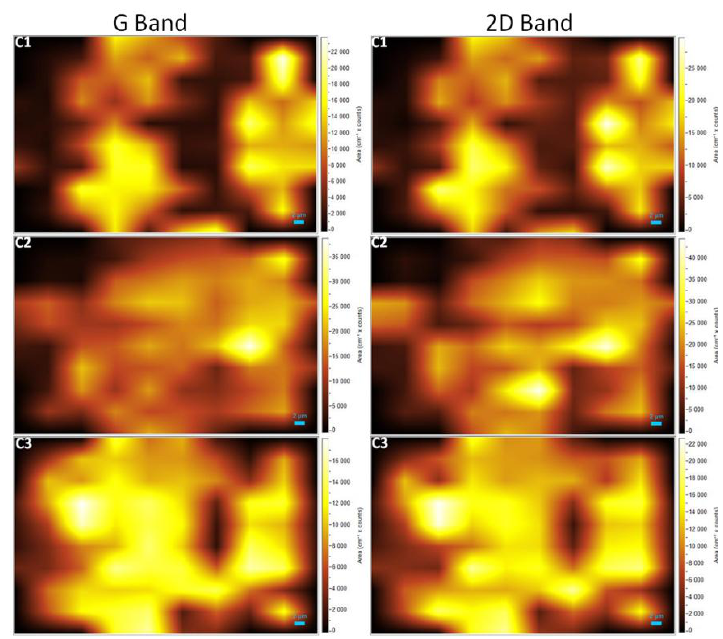
Figure 3. Raman mapping of the samples corresponding to G and 2D bands.